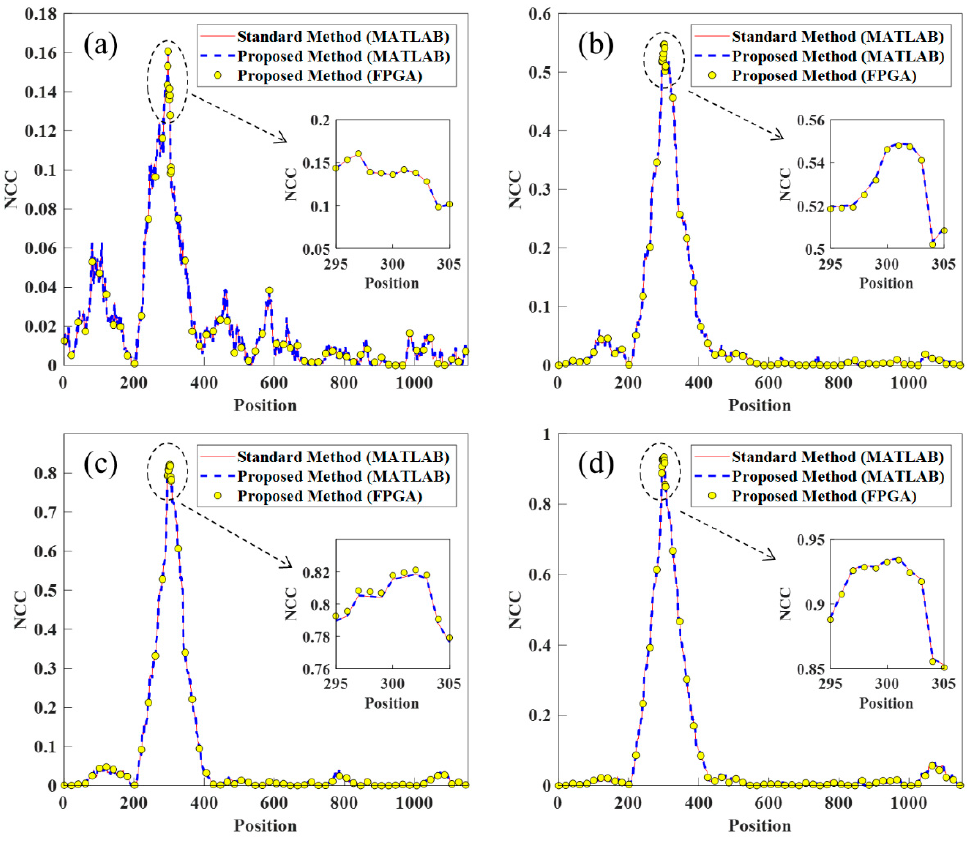
Figure 5. NCC deviation between different methods and platforms with different signal to noise ratios (SNRs): ( a ) SNR = 5 dB, ( b ) SNR = 10dB, ( c ) SNR = 15 dB, and ( d ) SNR = 20 dB.